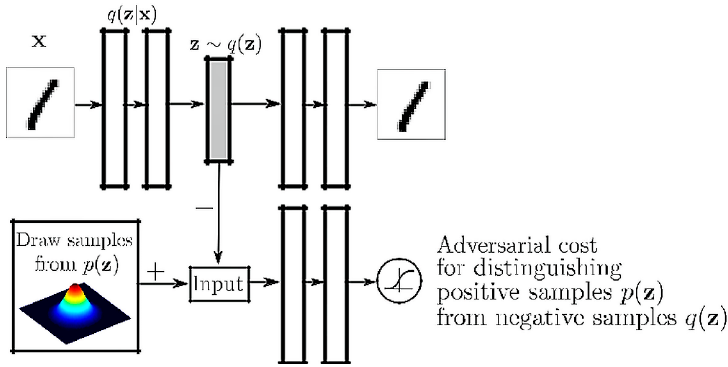
Figure 5. Adversarial autoencoder [32].